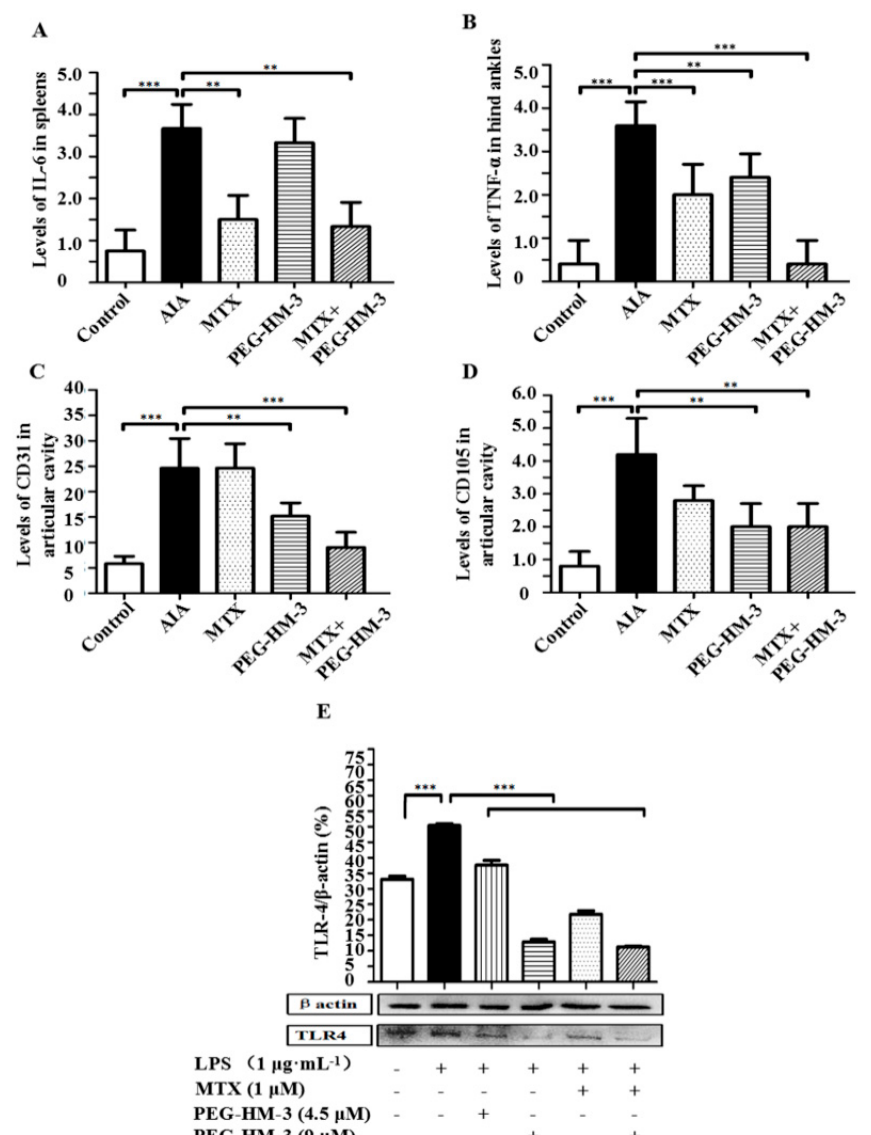
Figure 4. Immunohistochemical and western blot analysis of the levels of cytokines and proteins. ( A ) IL-6 expressions in spleens; ( B ) TNF- α expressions in hind ankles; ( C ) Levels of CD31 in joint cavity; ( D ) Levels of CD105 in joint cavity; ( C , D ) n = 5–8 in each group, × 200 magnification); ( E ) Western blot analysis of expressions of TLR-4 in synovial of rat ( n = 3). The one-way ANOVA was used for group comparison. Versus LPS group, ** p < 0.01 or *** p < 0.001.